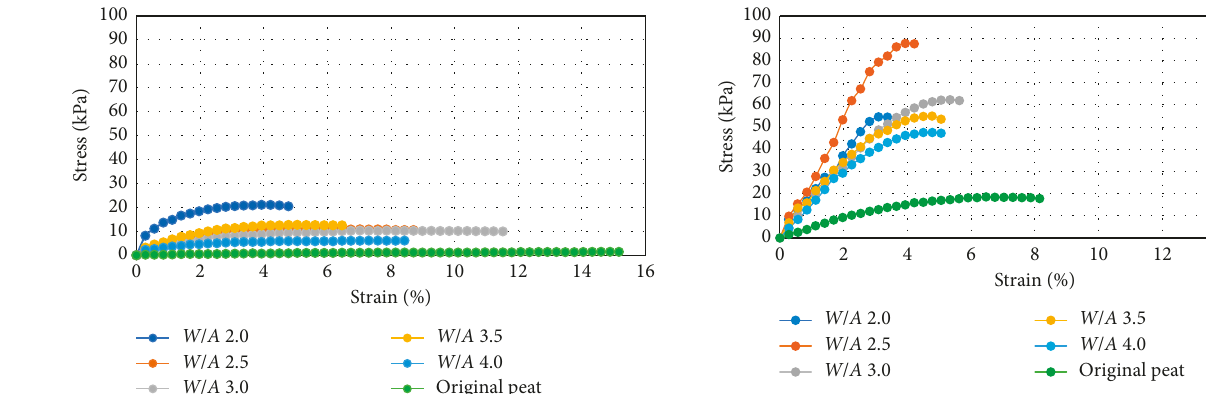
Figure 6: Stress vs. strain of peat C specimens after 56 days air- cured.